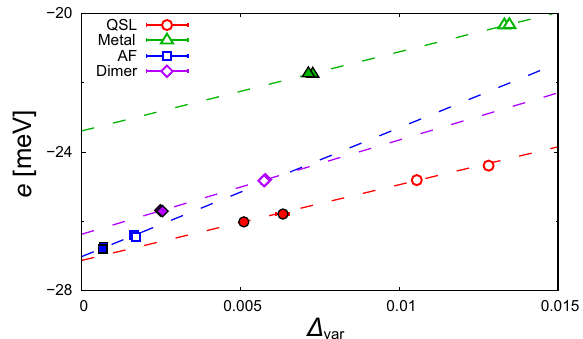
Fig. 7 Example of the variance extrapolation of the energy to determine the ground state. The example is shown for the ab initio Hamiltonian for X = EtMe 3 Sb. The variance is de fi ned as (cid:8) (cid:6) Δ ¼ ð H 2 (cid:2) H h i 2 Þ = H h i 2 . e represents the energy per site. Red var circles, blue squares, green triangles and purple diamonds represent the energies of the QSL, the AF, a metal, and a spin-gap state with a fi nite dimer order along x direction, respectively. Open and fi lled symbols are obtained by using the VMC method and the VMC combined with 1st-step Lanczos method, respectively, to each of which we also apply the restricted Boltzmann machine, which enables the lower energy. Dashed lines are fi tted lines for the variance extrapolations. We impose the 1 × 1 and 2 × 1 sublattice structures on the trial wavefunction for the metal and the dimer state, respectively. In all the data plot, error bars obtained in the VMC calculation are smaller than the symbol size.